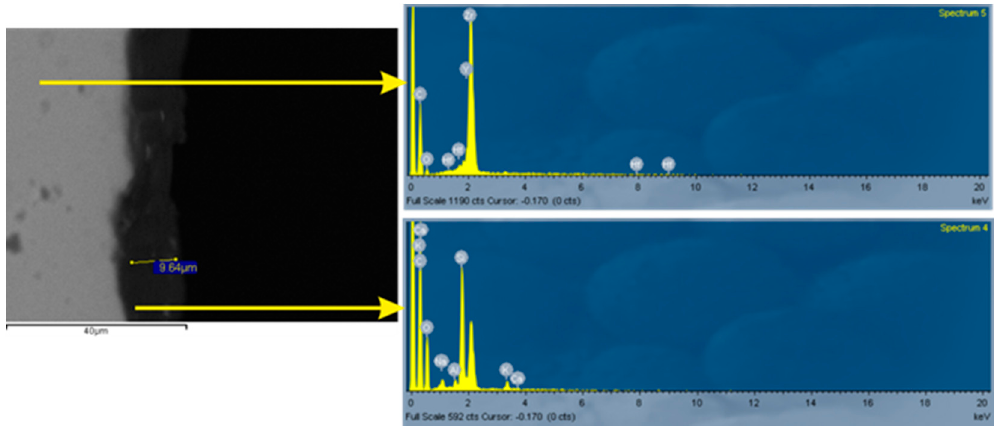
Figure 3. SEM atomic-number contrast backscattered electron image of a cross-sectioned glazed monolithic zirconia specimen and associated EDS analyses. Dispersed phases with a grayscale level matching that of the substrate are apparent in the glaze film. Top EDS spectrum: ground zirconia substrate, bottom EDS spectrum: glaze layer.